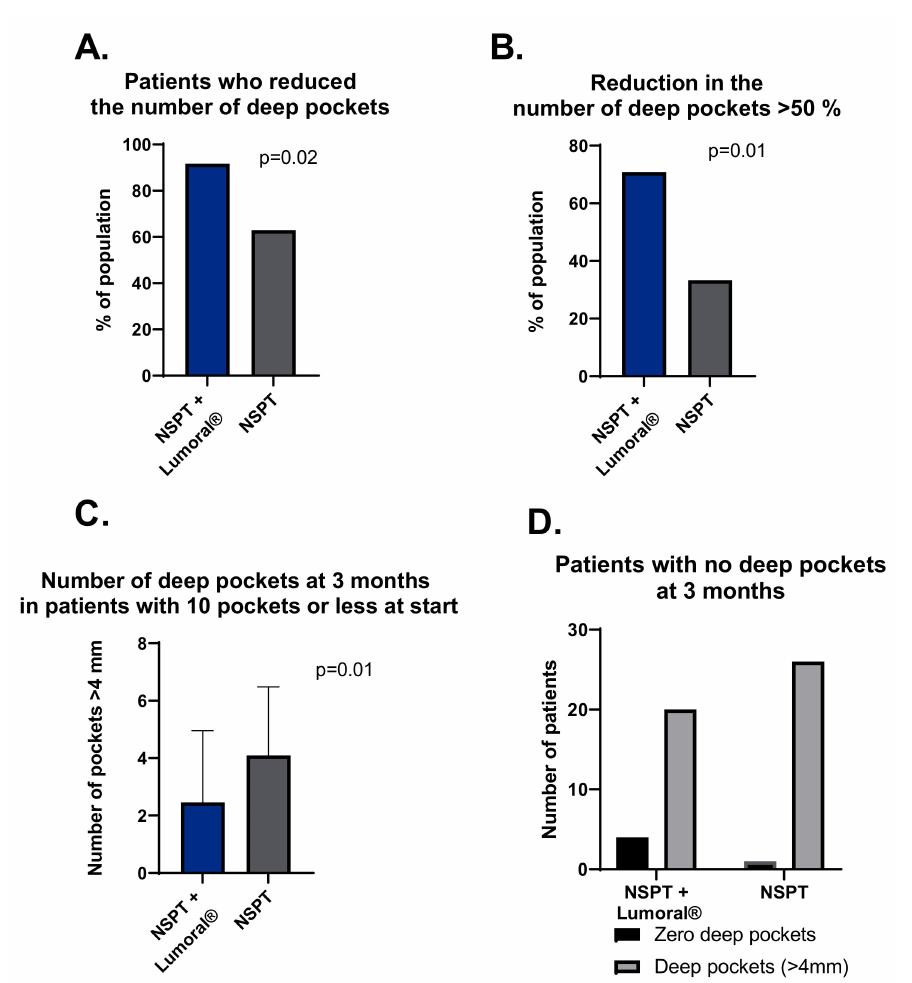
Figure 5. ( A ) Proportion of the patients who reduced the number of their deep periodontal pockets. ( B ) The number of patients with a reduction of 50% or more in the number of deep pockets at three months. ( C ) Number of deep pockets at three months in patients who had ten pockets or fewer at the beginning of the study. ( D ) The number of patients who presented no deep pockets at three